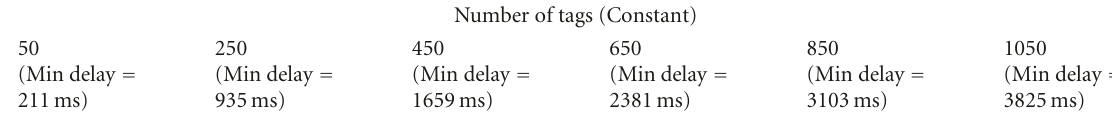
Table 3: The ICW and the coe ffi cient values, C , giving lowest energy consumption (Energy) when choosing a specific delay and a specific number of tags for the constant